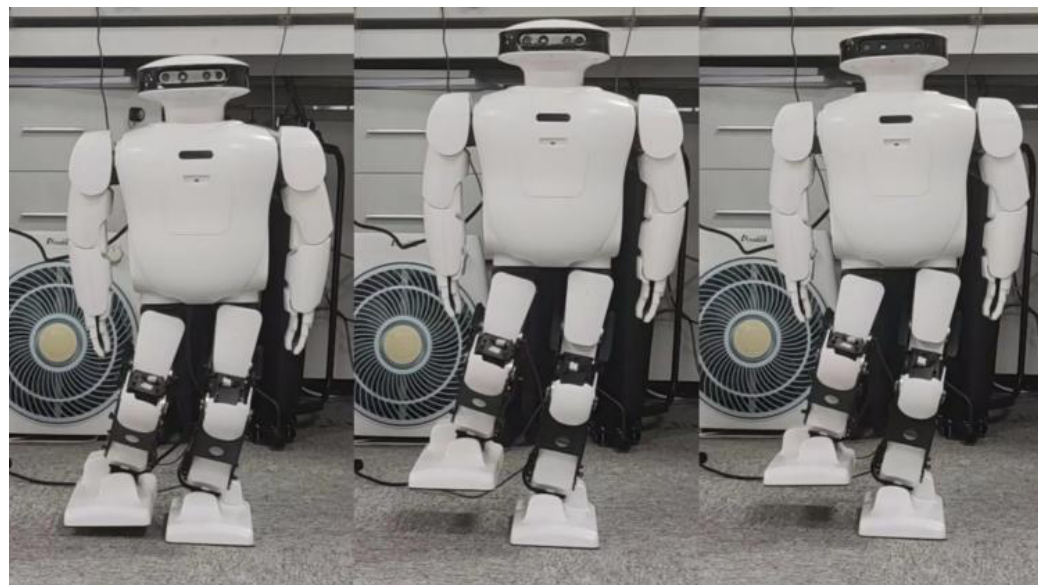
Figure 17. When Roban’s COM moves 4.3 cm, the robot completes the squat by means of spring compensation.